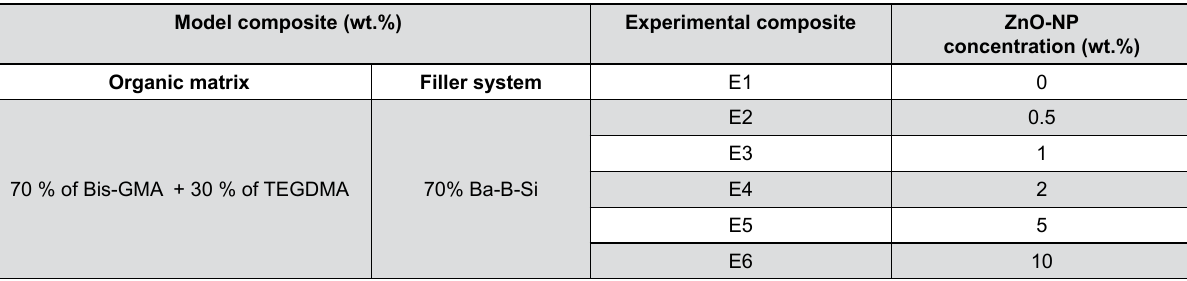
Figure 1- Composition of the experimental